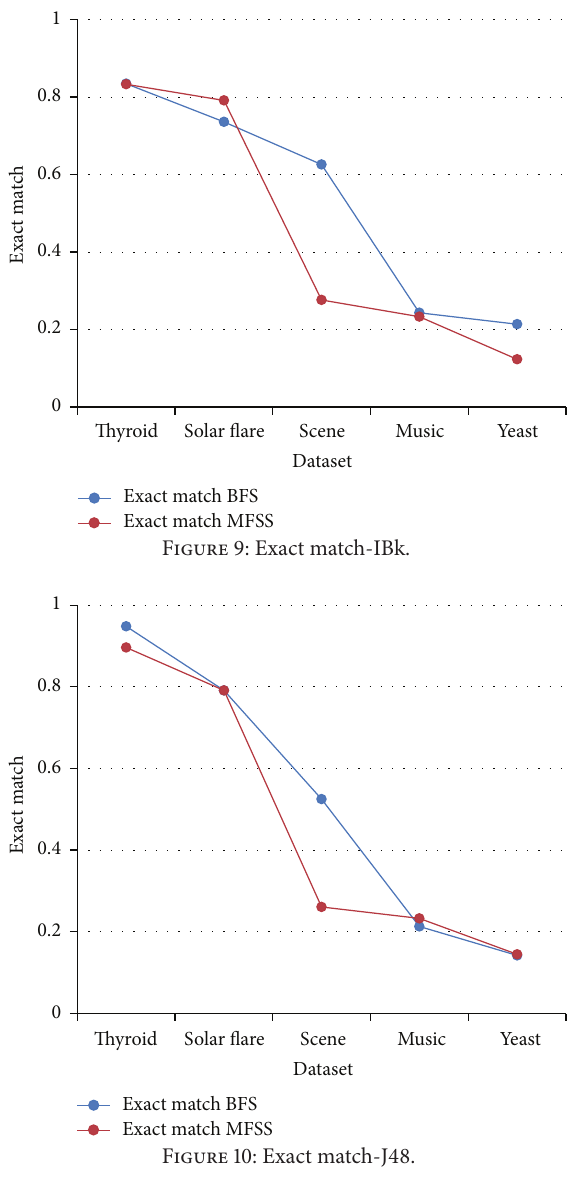
Figure 9: Exact match-IBk.